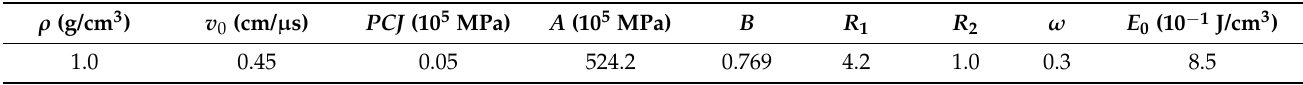
Table 2. Material parameters of explosive model.